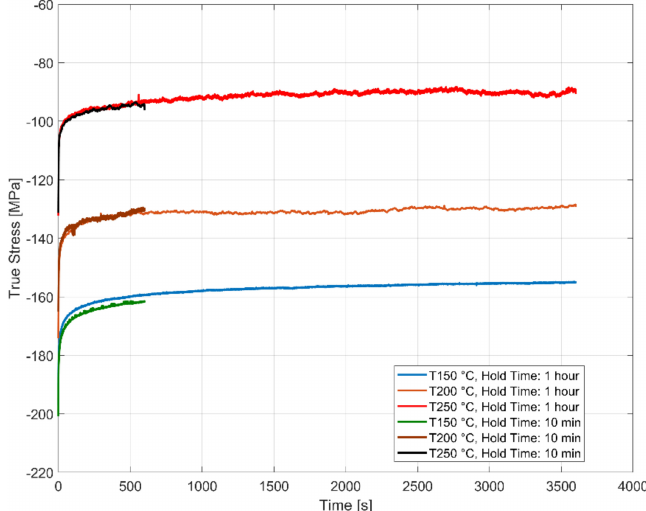
Figure 6. E ff ect of hold time on stress relaxation at various temperatures with the total strain held constant at ε Hold = −